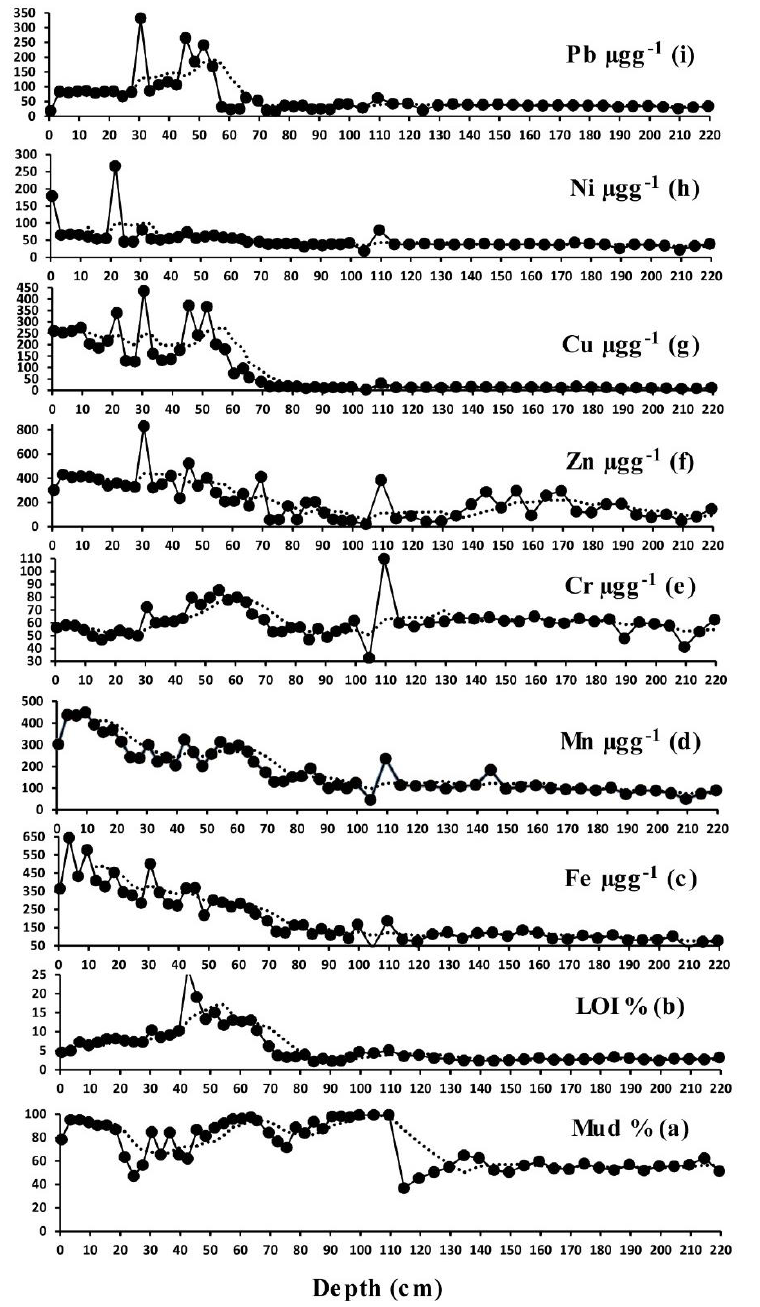
Figure 3. ( a , b )Vertical distribution of mud and LOI %, ( c – i ) Vertical distribution of metal concentra- tions in the Salam1 core from Al-Salam Lagoon along the Jeddah coast, Saudi Arabia (trend line of 5 Average is shown by dots).